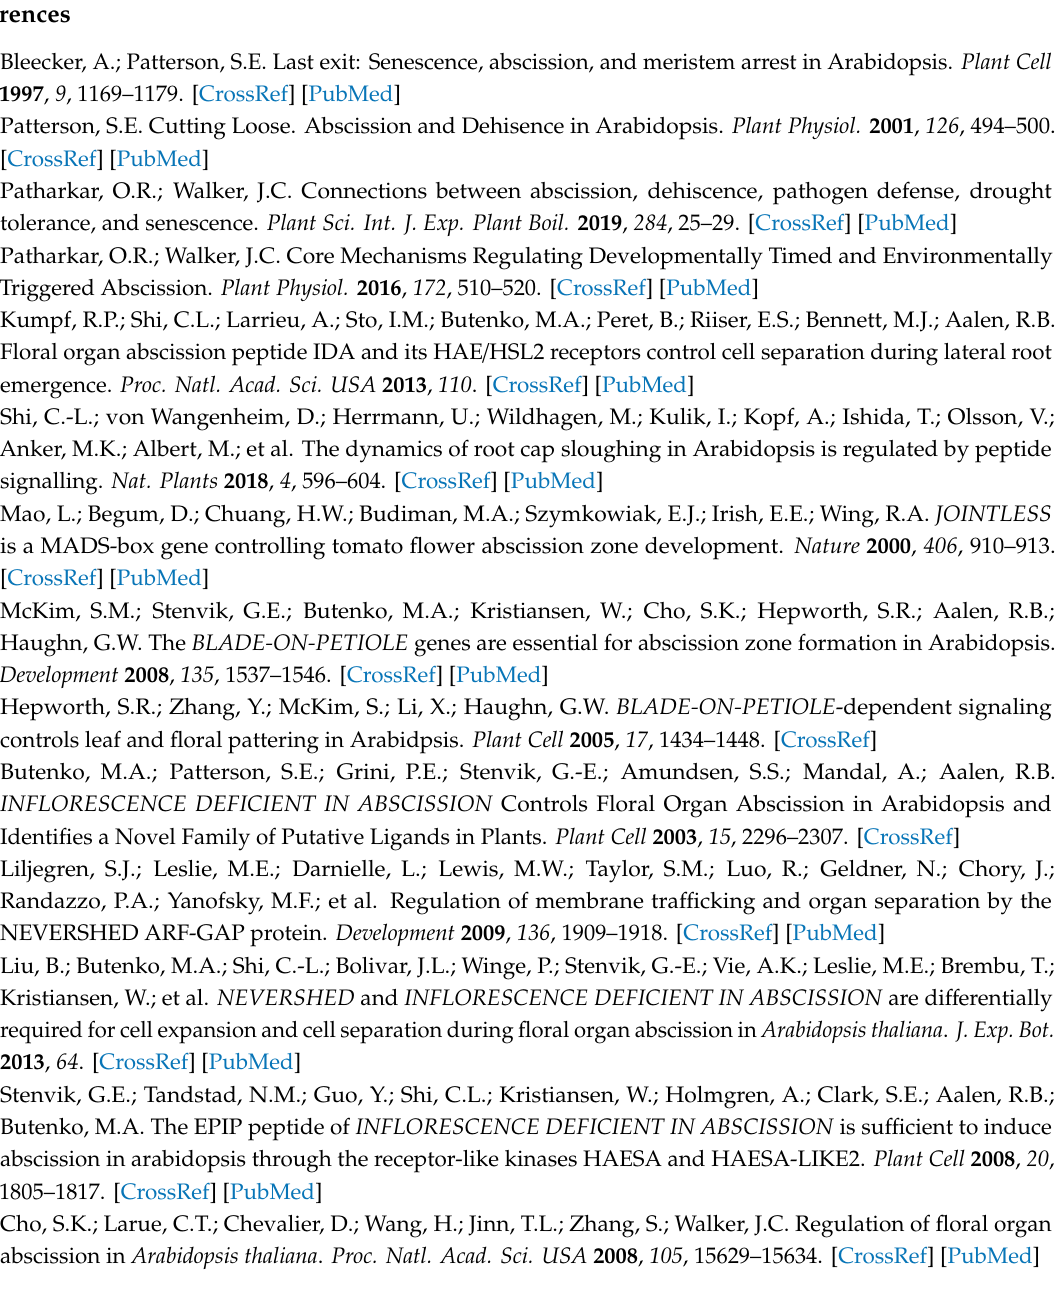
Figure S1: The double mutant hae hsl2 is, like the ida mutant, totally deficient in abscission, Figure S2: Orthologous angiosperm sequences IDL6-8, Figure S3: Structure-based sequence alignment of the 21 leucine-rich repeats (LRRs) comparing Arabidopsis HAE and HSL2 with EgHSL2 from oil